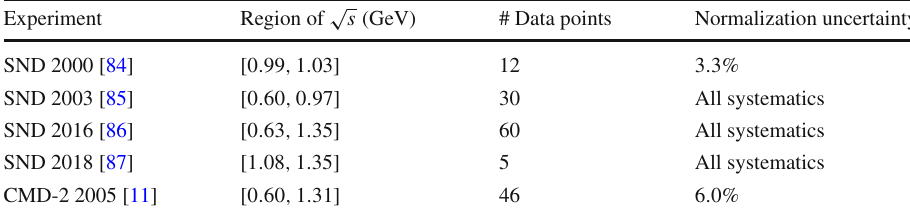
Table 1 Summary of the e + e − → π 0 γ data sets. For [87] only data points for √ s < 1 . 4GeV are included, as the cross section in the region ( 1 . 4–2 . 0 ) GeV was found to be consistent with zero. In the last column we indicate the size of the systematic errors that we interpret as a normalization-type uncertainty and therefore assume to be 100% correlated